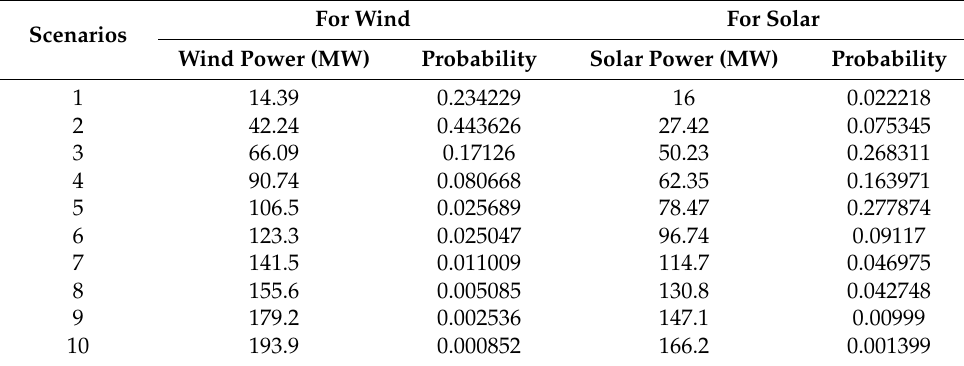
Table 7. Ten reduced renewable power